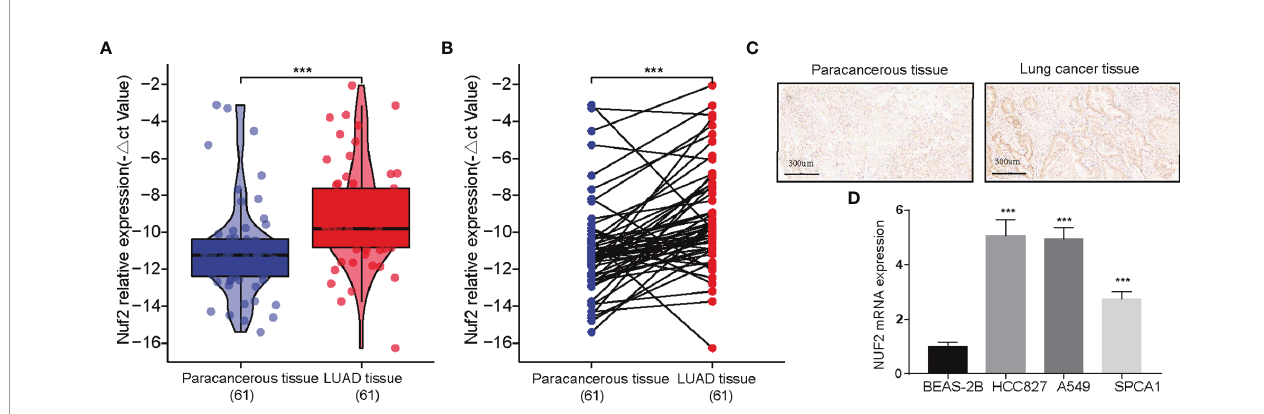
FIGURE 2 | Expression analysis of NUF2 in lung adenocarcinoma (LUAD). (A, B) Qualitative real-time PCR analysis of NUF2 in tumor and adjacent samples from our recruited cohort. (C) Immunohistochemical (IHC) staining sections for NUF2 of lung cancer tissues and cancer-adjacent normal lung tissues. (D) Differential expression of NUF2 in in LUAD cell lines and normal lung epithelial cell line 2B. ***p < 0.001.